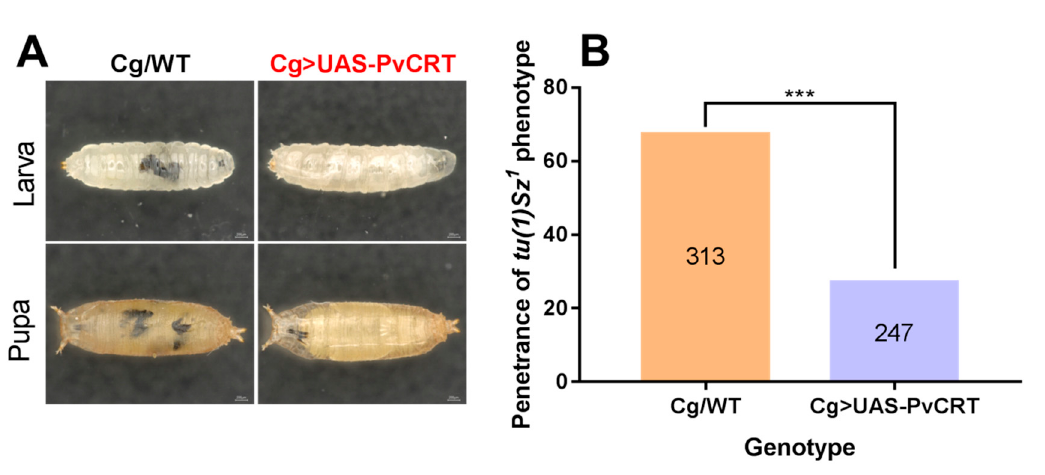
Figure 7. PvCRT inhibited encapsulation of the host. ( A ) Microscopic inspection of self-encapsulation phenotype in larvae and pupae between control and transgenic lines. ( B ) Penetrance of tu(1)Sz 1 phenotype in the pupal Drosophila . Significant difference was marked with “***” ( p < 0.001, Fisher Exact test), the numbers indicated independent replicates for each treatment.